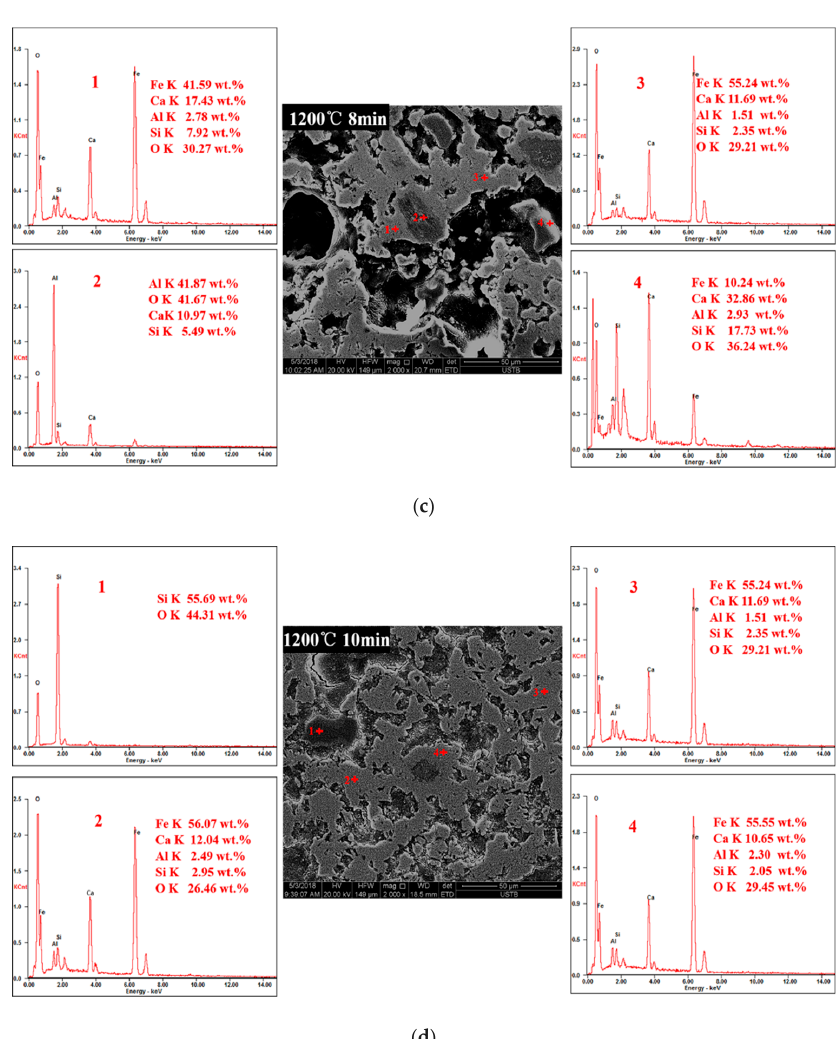
Figure 10. SEM and EDS results of sample C sintered at 1200 °C at different times ( a ) 4 min ( b ) 6 min ( c ) 8 min ( d ) 10 min.